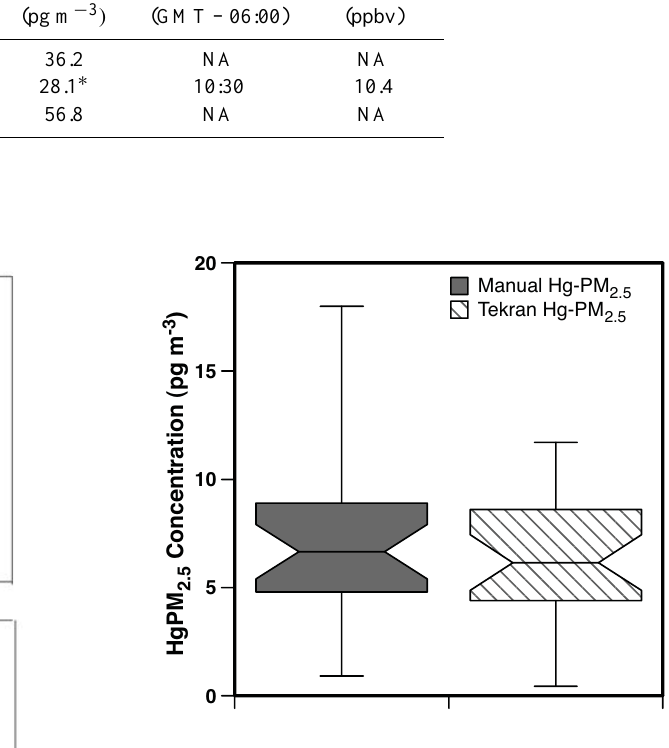
Fig. 5. Boxplot showing overlap in concentration ranges for 12-h sampling, 25 July–5 August,